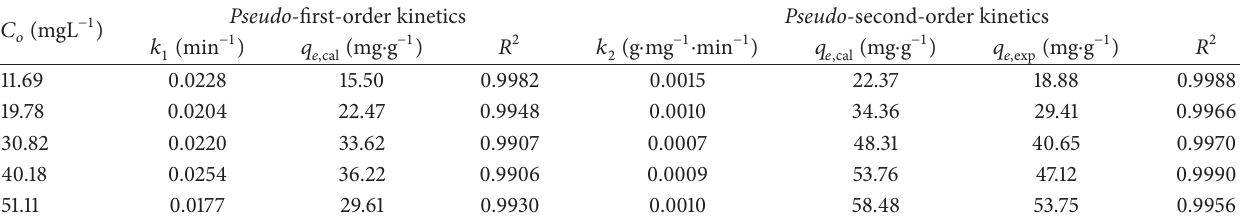
Table 2: Adsorption kinetic parameters for Ni(II) adsorption on the Fe 3 O 4 /rGO composite. −1 𝐶 𝑜 (mgL